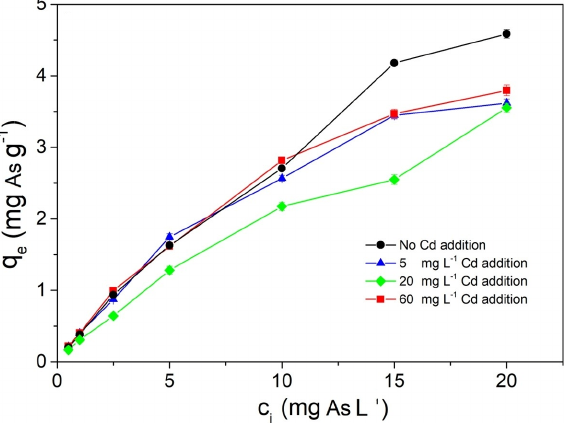
Figure 25. The effect of adding Cd(II) on the adsorption capacity of As(III) under different initial concentrations [143]. Reprinted with permission from Jizi Wu et al. (2018). Copyright 2018, Elsevier.